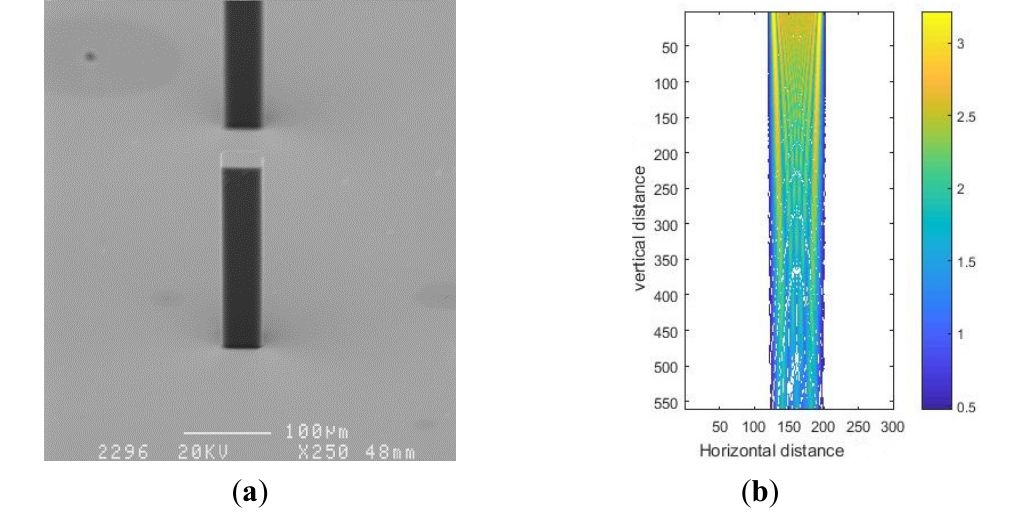
Figure 17. SEM photo of a SU-8 pillar ( a ) and simulation result ( b ) for mask hole size of 30 μ m.